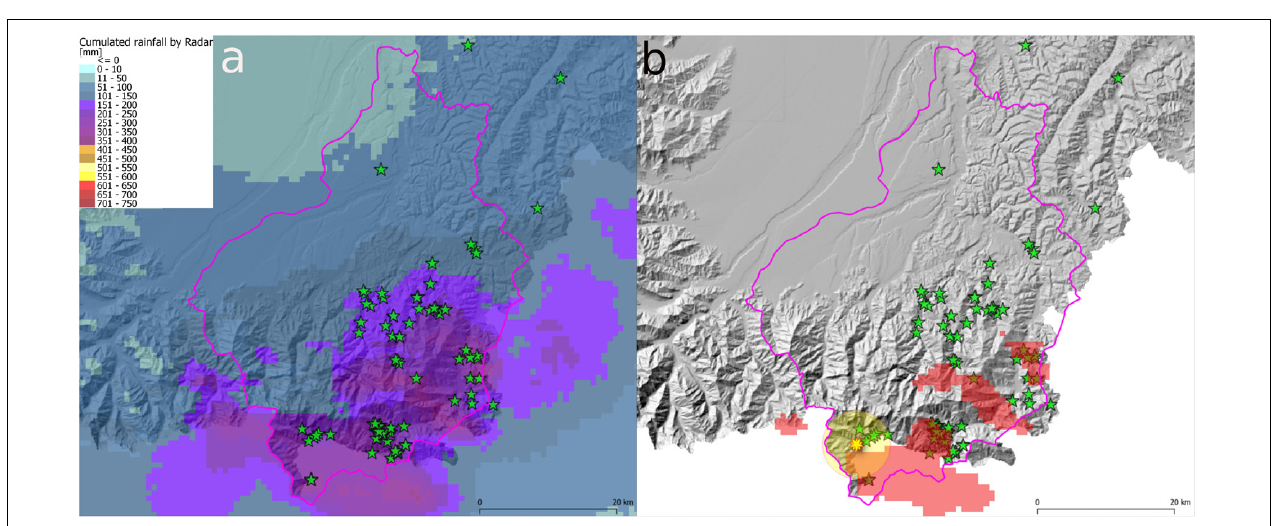
FIGURE 6 | (a) Accumulated rainfall from 24th November at 03:00 UTC in Alto Tanaro. (b) In red, areas interested by precipitations that overpassed thresholds of Equation 2 (critical rainfall accumulations) and rain gages overpassing threshold (yellow asterisks) and related buffers (yellow circles); green star labels indicate occurred